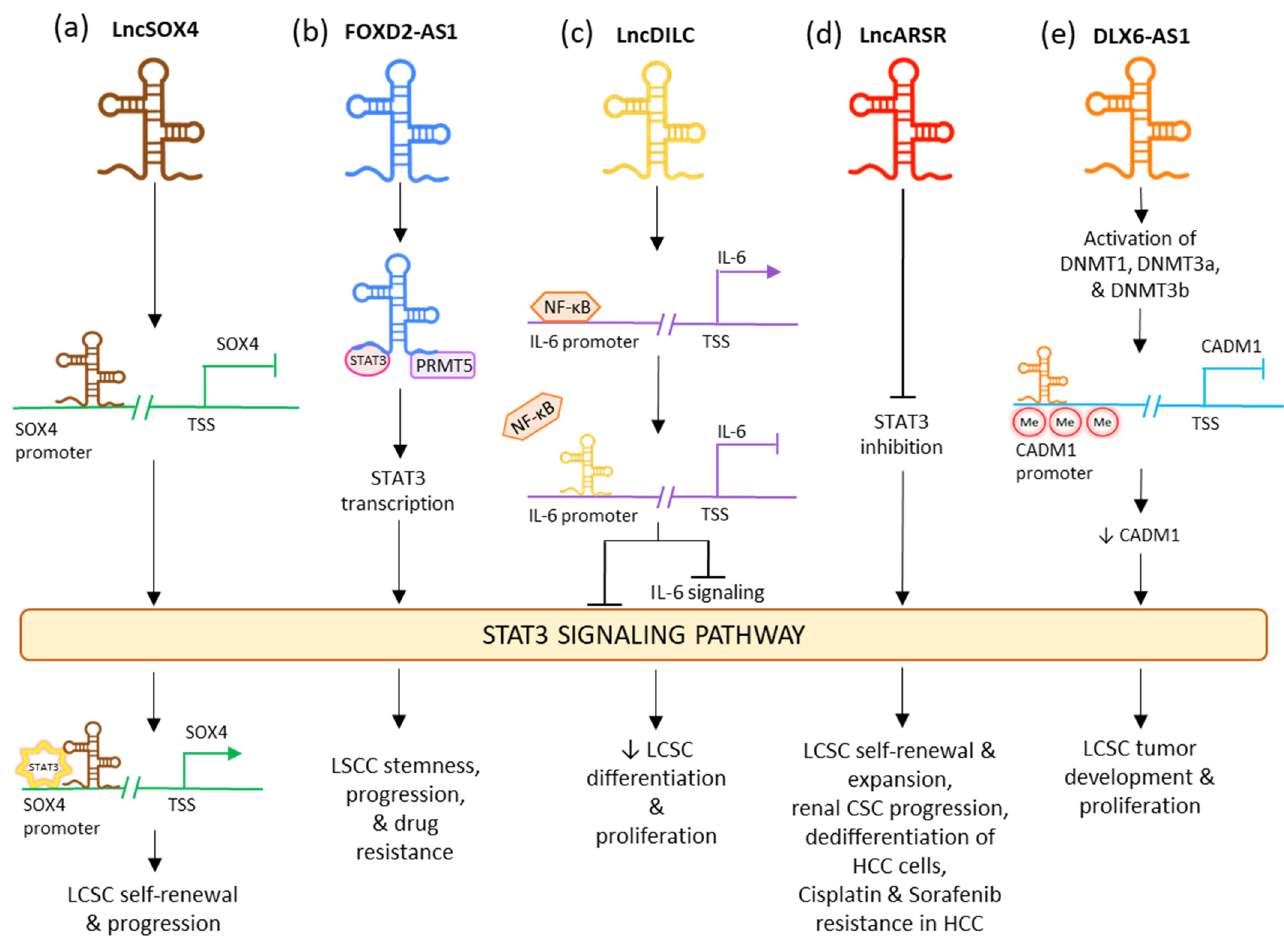
Figure 4. Influence of different lncRNAs on STAT3 CSC signaling pathway.